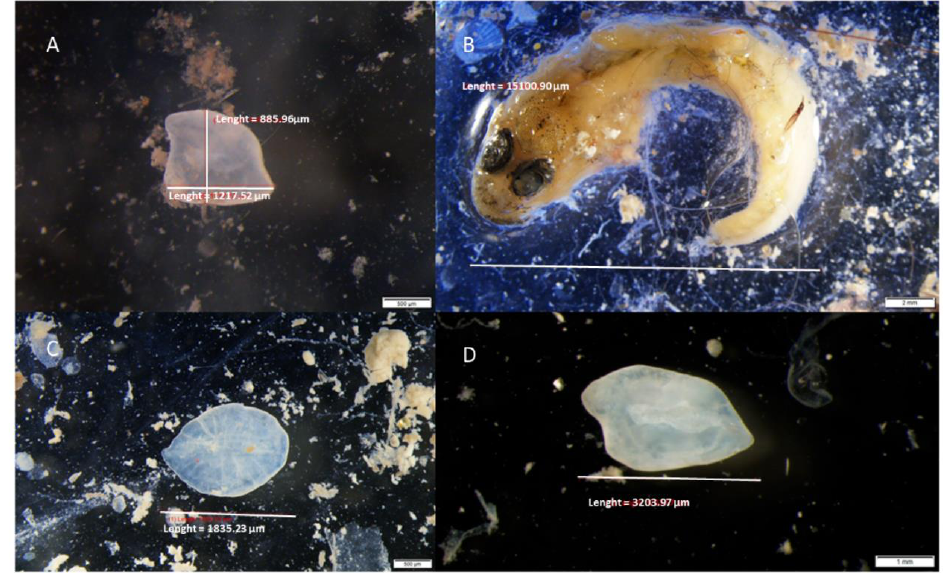
Figure 4. Otoliths and undigested Gobius sp. found in fecal pellets of S. scriba: ( A ) otolith of Gobius cruentatus , ( B ) Gobius sp., ( C ) otolith of Atherina hepsetus and ( D ) Gobius fallax.